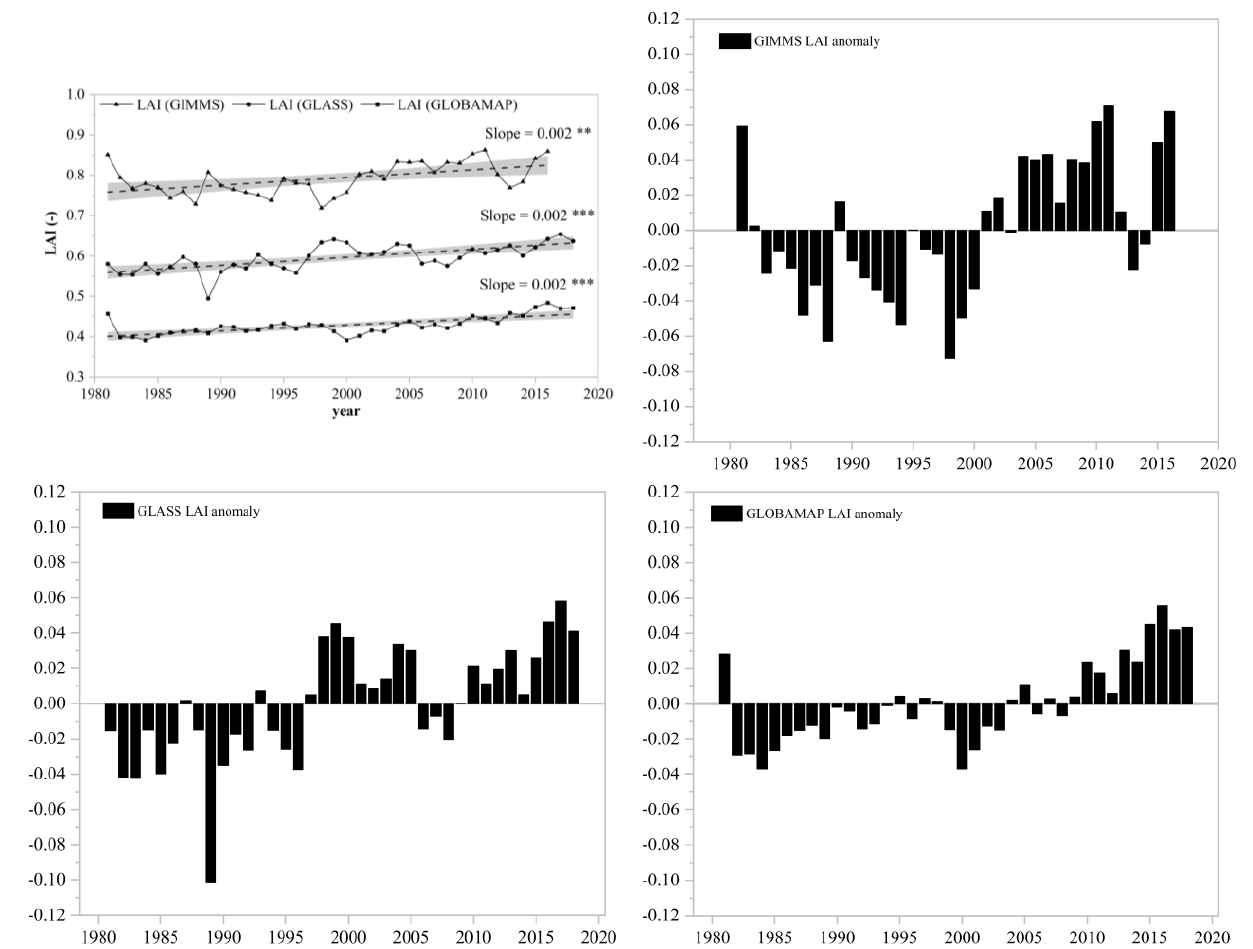
Figure A4. Temporal variation trends and anomalies of GLASS, GIMMS and GLOBAMAP LAI (**, p < 0.01; ***, p <